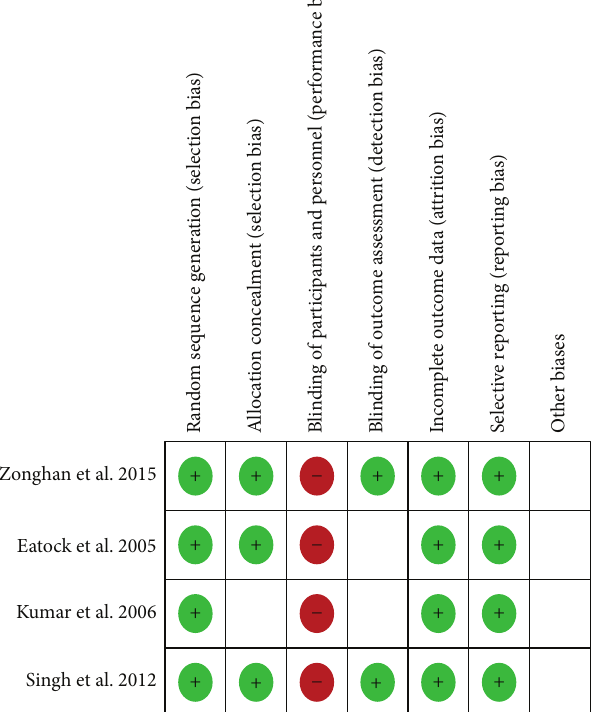
Figure 1: PRISMA flow chart for the study selection process.